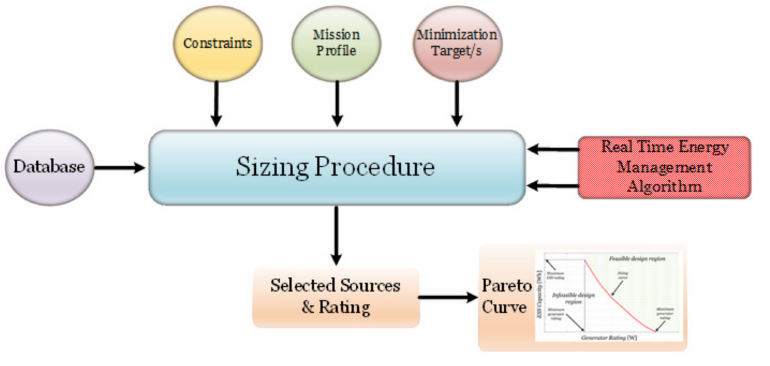
Figure 6. Sizing